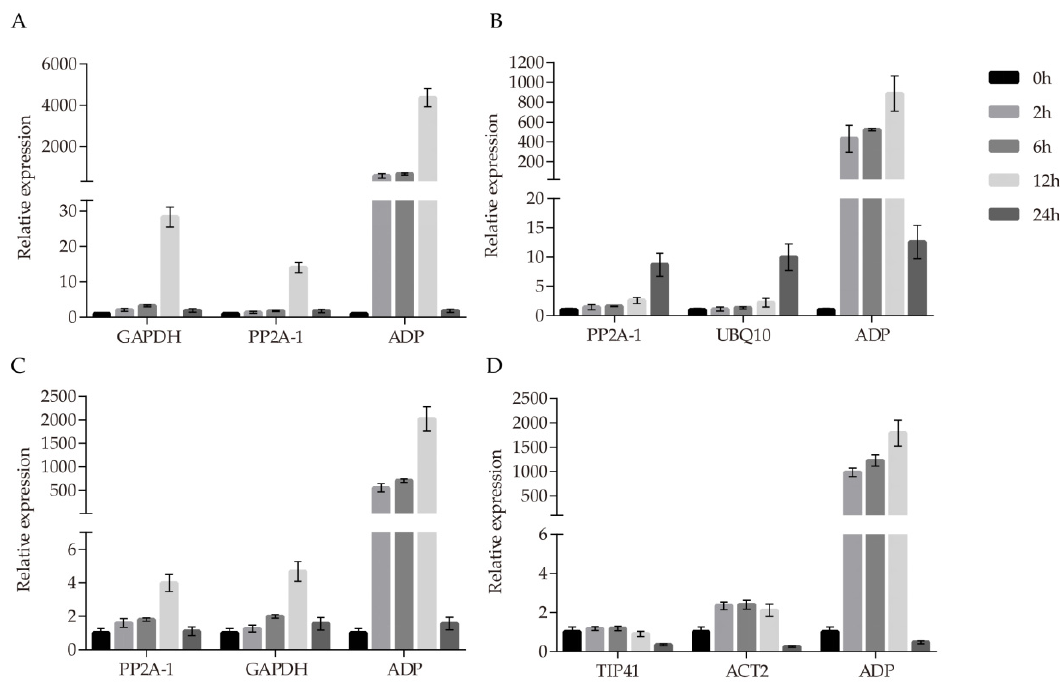
Figure 5. Relative expression of LoCAT gene under abiotic stresses normalized using the top two stable RGs and one unstable RG. ( A ) Drought stress. ( B ) Salt stress. ( C ) Cold stress. ( D ) Heat stress.